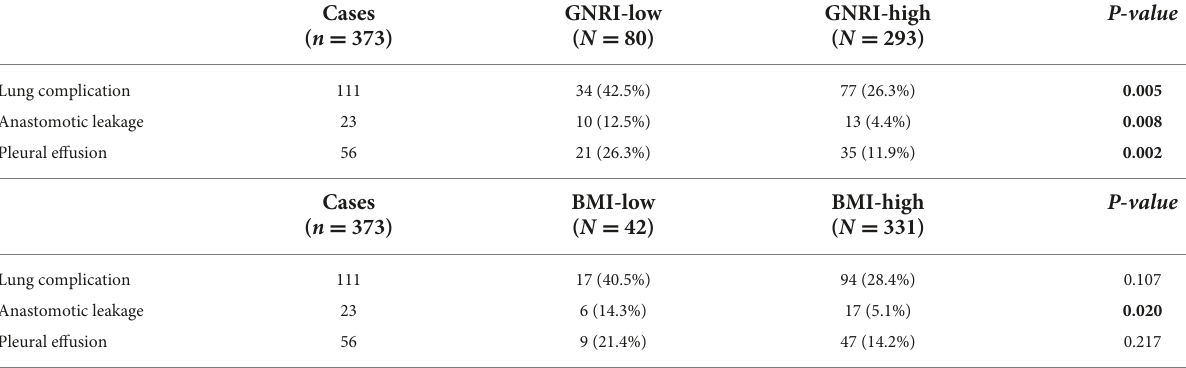
TABLE 2 Postoperative complications stratified by geriatric nutritional index (GNRI), the level of serum albumin, and body mass index (BMI) value.